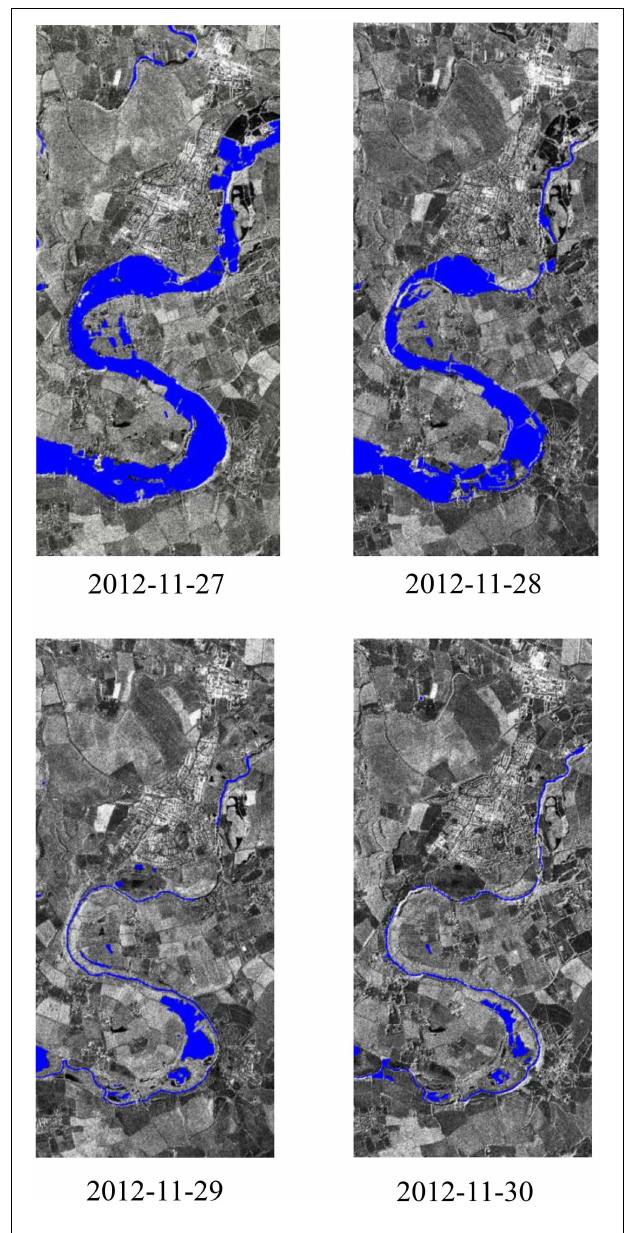
FIGURE 10 | Flood extents (blue) for the event of November 2012 overlain on SAR imagery of the flooded 11km reach of Figure 9A (© CSK) (after Mason et al.,